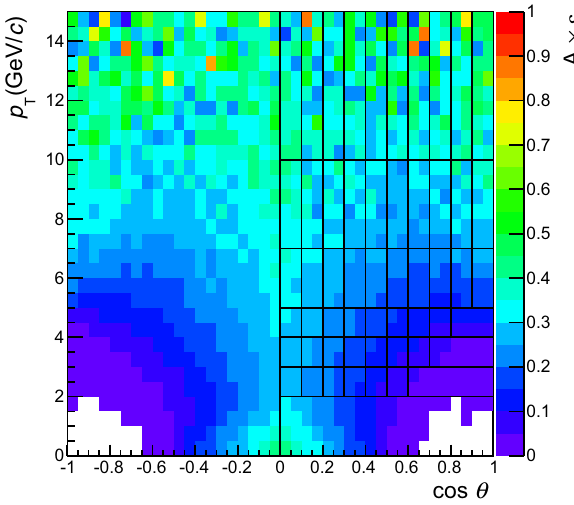
(right), while the grid shows the binning used to build the W 1 ( cos θ) and W 2 (ϕ) distributions in each p T range